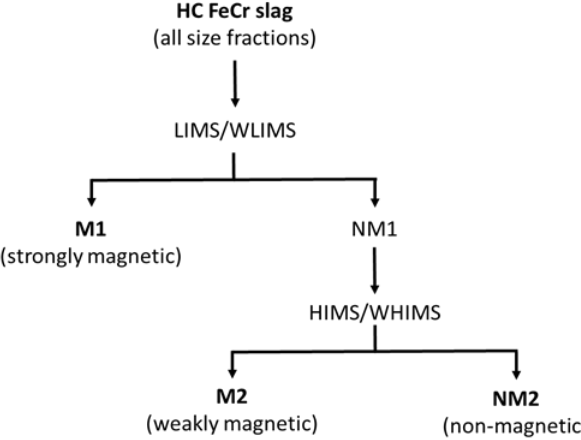
Figure 6. Combination of low and high intensity magnetic separation used for HC FeCr slag. (LIMS and HIMS for fractions >500 µm and WLIMS and WHIMS for fractions <500 µm).